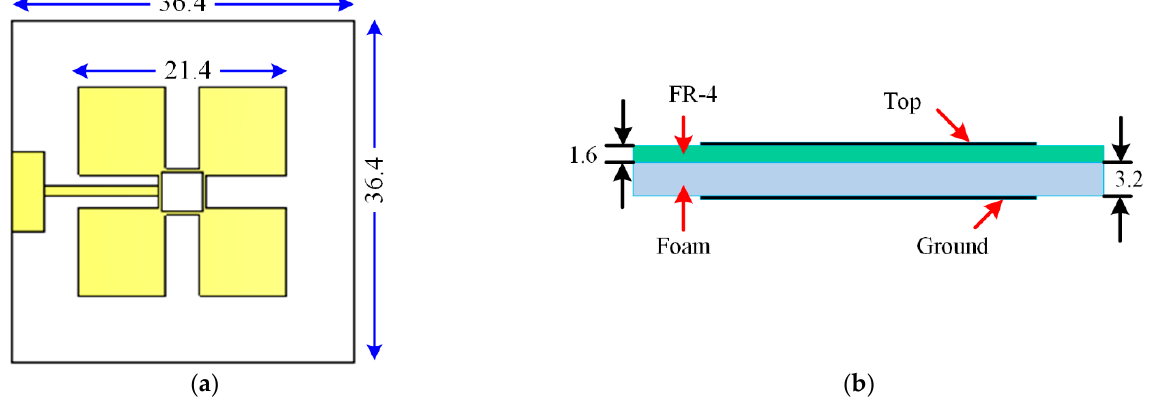
Figure 15. The modified single band antenna ( a ) top view and ( b ) side view (units: mm).